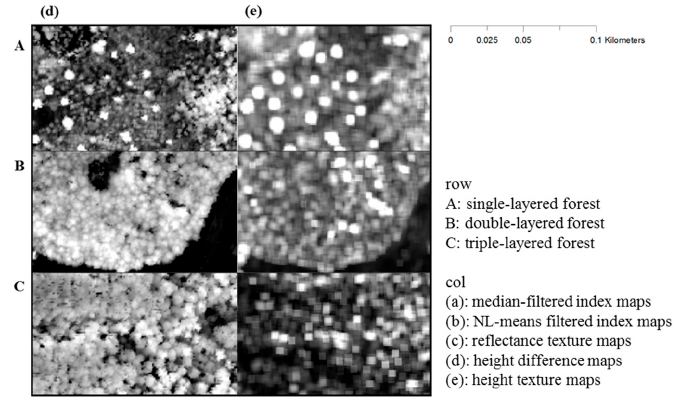
Figure 6. Characteristics of the five input layers used for the ANN approach in boxes A, B, and C of Figure 3: ( a ) median-filtered index maps; ( b ) NL-means filtered index maps; ( c ) reflectance texture maps; ( d ) height difference maps; and ( e ) height texture maps. The areas in boxes A, B, and C are the single-, double-, and triple-layered forests, respectively.